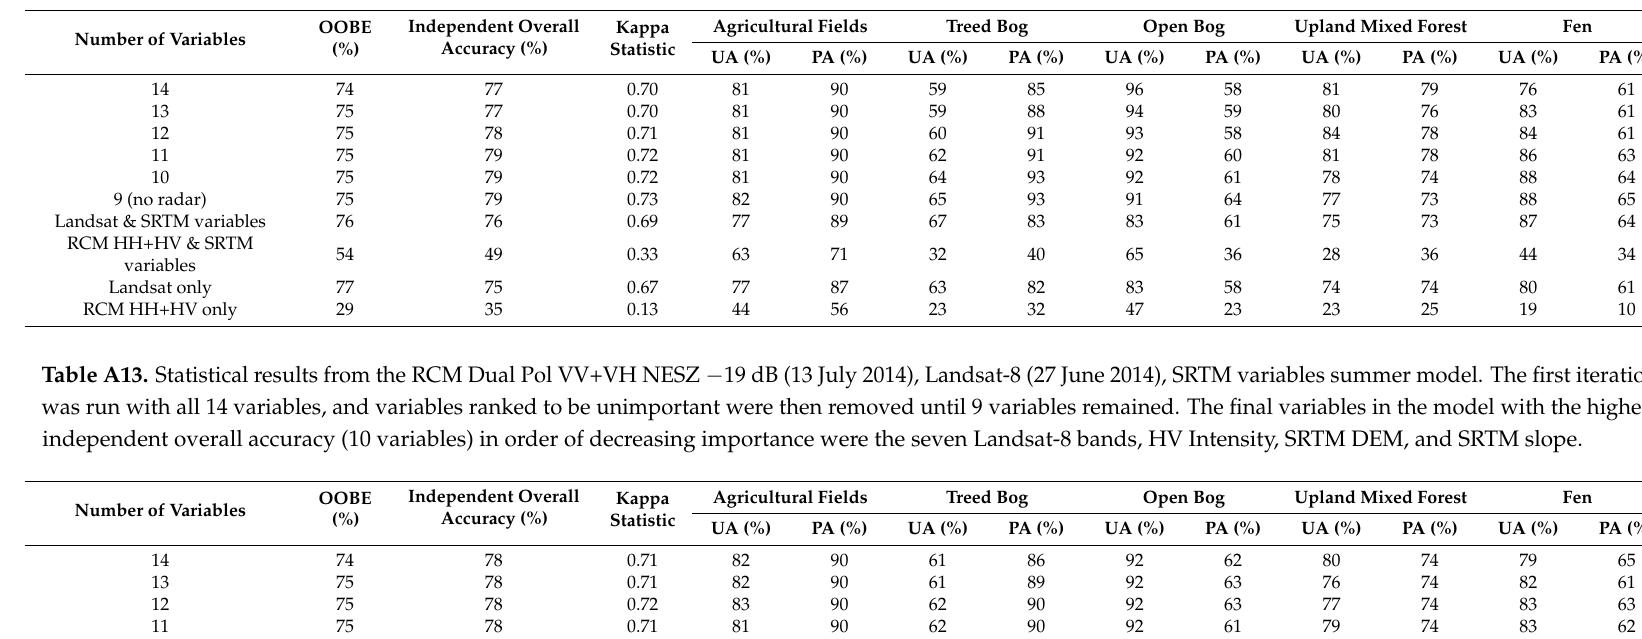
Table A12. Statistical results from the RCM Dual Pol HH+HV NESZ − 25 dB (13 July 2014), Landsat-8 (27 June 2014), SRTM variables summer model. The first iteration was run with all 14 variables, and variables ranked to be unimportant were then removed until 9 variables remained. The final variables in the model with the highest independent overall accuracy (10 variables) in order of decreasing importance were the seven Landsat-8 bands, HV Intensity, SRTM DEM, and SRTM slope.